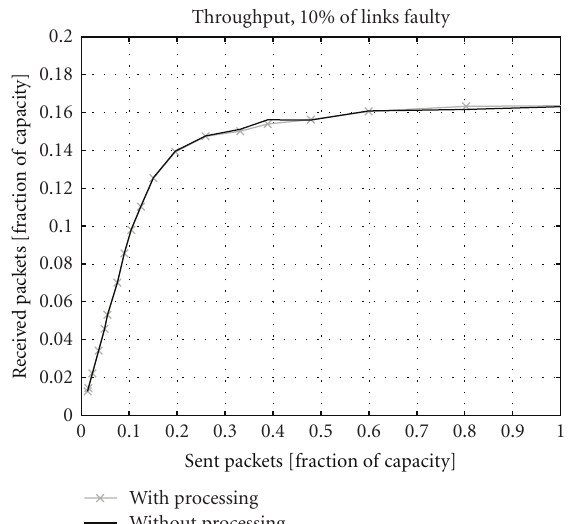
Figure 9: Throughput with and without processing. C size = 5, 10% of links are